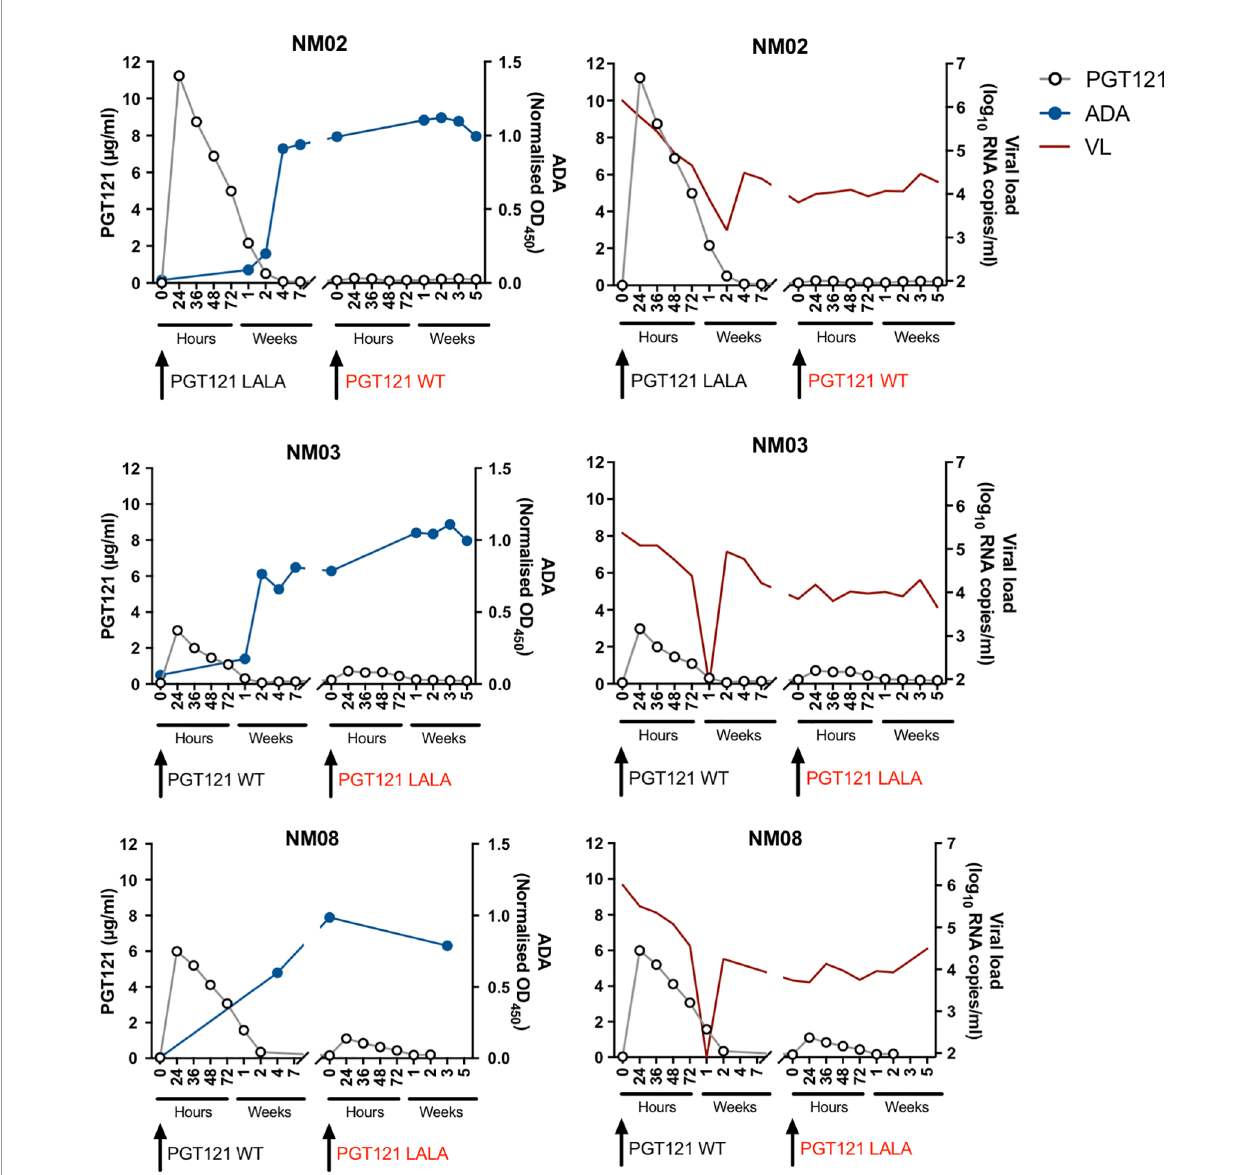
FIGURE 2 | Anti-PGT121 antibodies limit the plasma concentration of PGT121 and diminish the therapeutic ef fi cacy of PGT121 against SHIV. The plasma concentration of PGT121 WT or LALA post-infusion (open circles, left y-axis) is plotted with the level of anti-PGT121 ADA (blue line, right y-axis) or SHIV viral loads (red line, right y-axis). Black arrows indicate antibody administration. The red text indicates failed therapy with PGT121 WT or